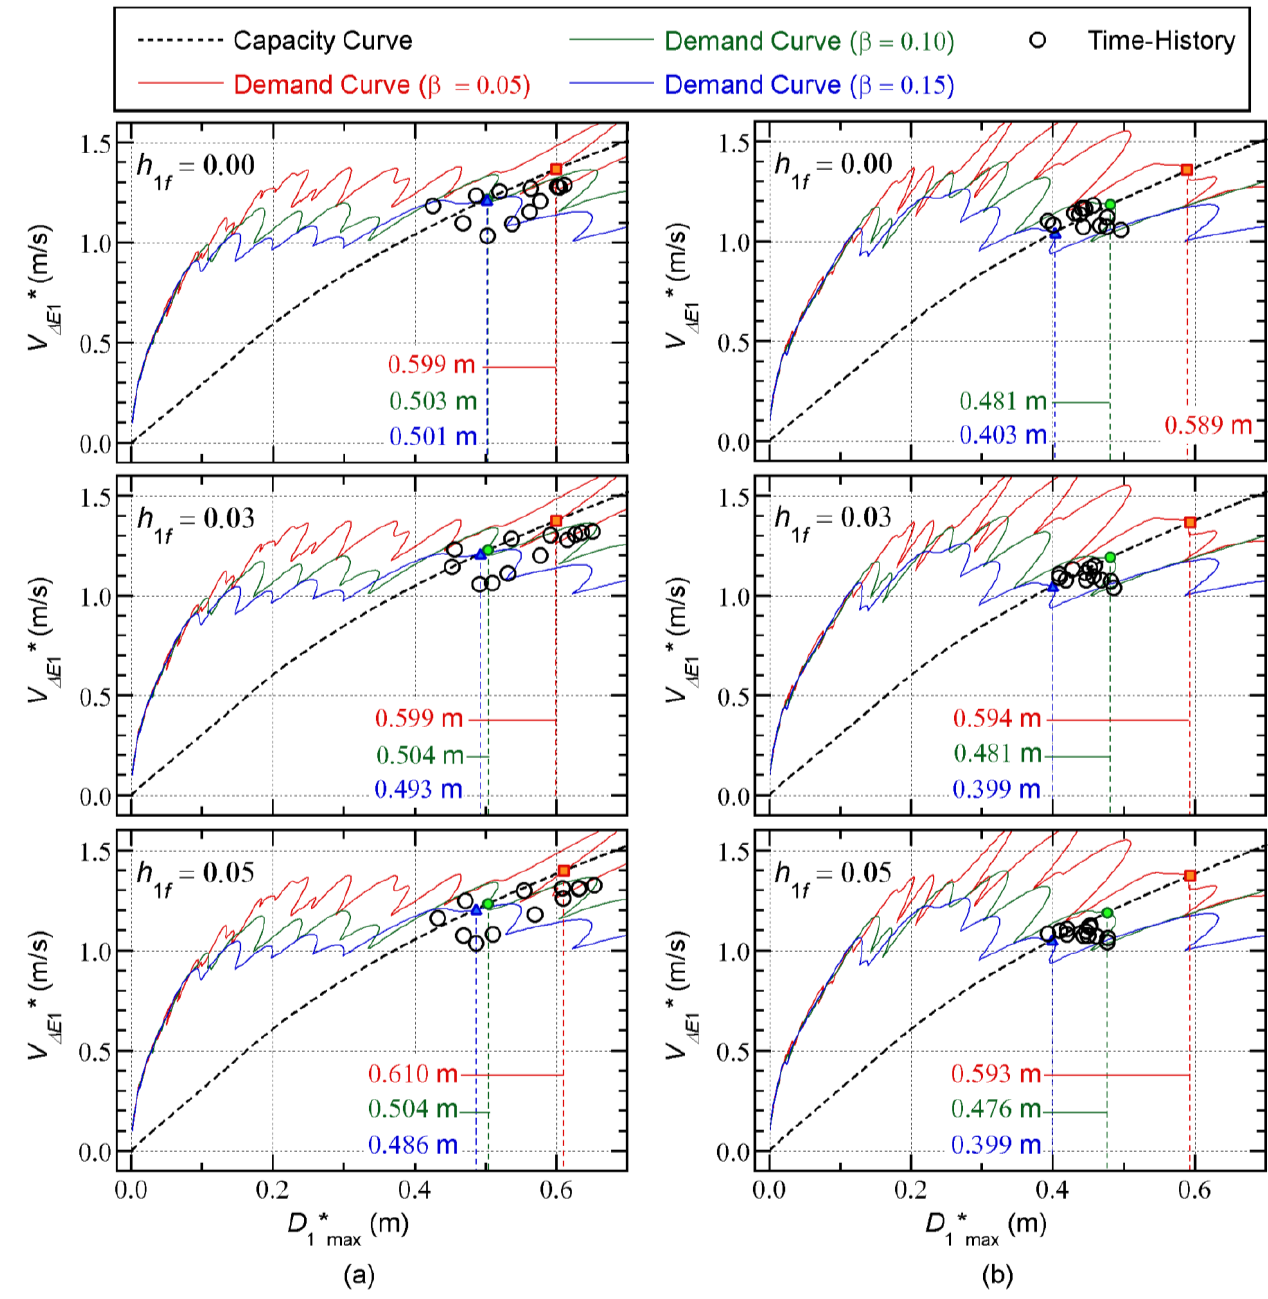
Figure 21. Comparisons between the capacity curve and the V ∆ E 1 ∗ - D 1 ∗ max relationship obtained from the time-history analysis results (16-story model): ( a ) Art-L series; ( b ) Art-S series.